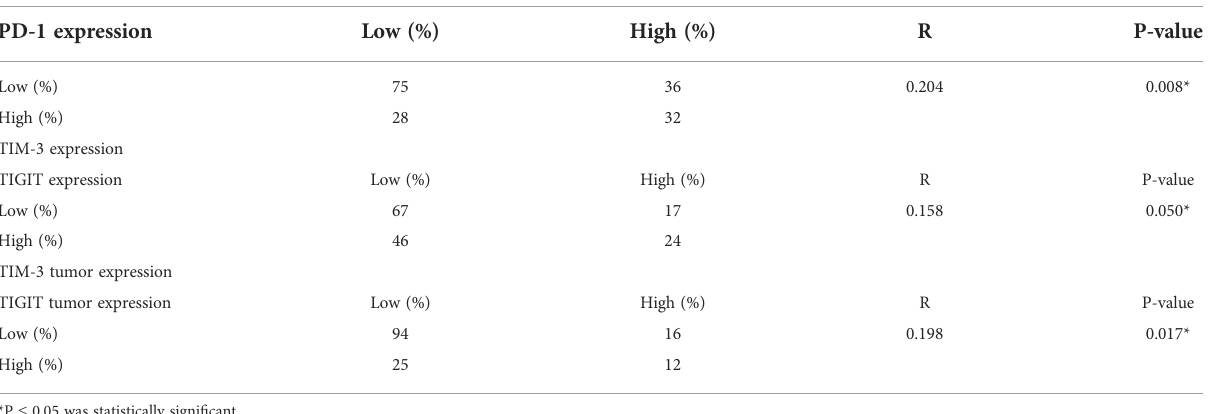
TABLE 4 Spearman correlation analysis of PD-1, LAG-3, TIM-3, TIGIT